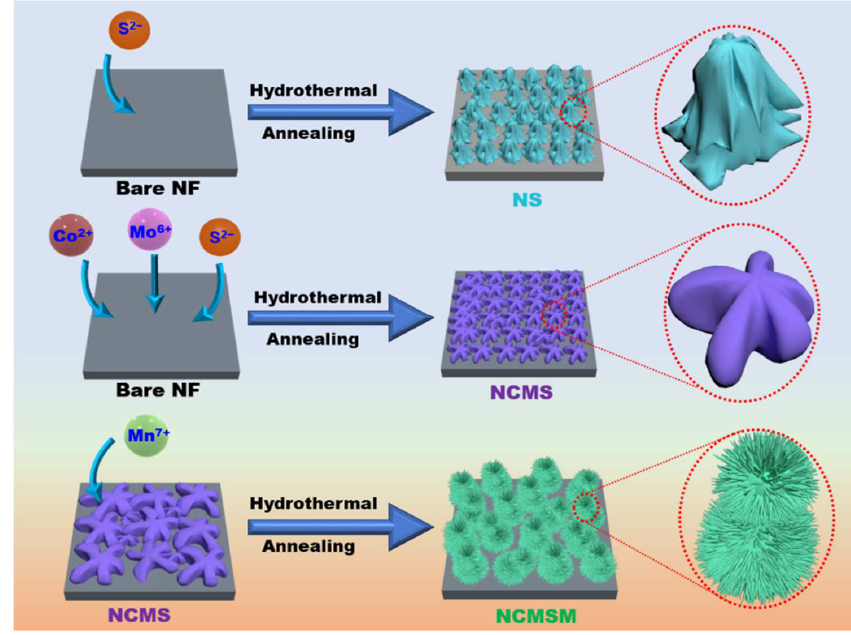
Figure 7. Schematic diagram showing the formation of NS, NCMS, and NCMSM.